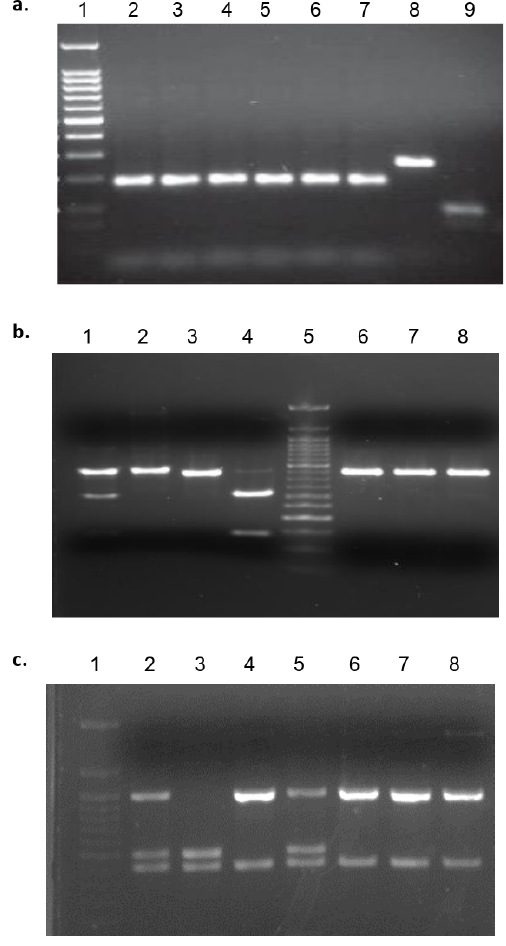
Figure 2. Trypanosoma cruzi genotyping. Initial discrete typing unit (DTU) assignment was per- formed evaluating the following single locus molecular: mini-exon gene, heat shock protein 60 (HSP60)/EcoRV and glucose-6-phosphate isomerase (GPI)/HhaI: ( a ) Representative agarose gel for Trypanosoma cruzi mini-exon genotyping. Lane 1: Molecular weight marker 50-bp ladder; Lanes: